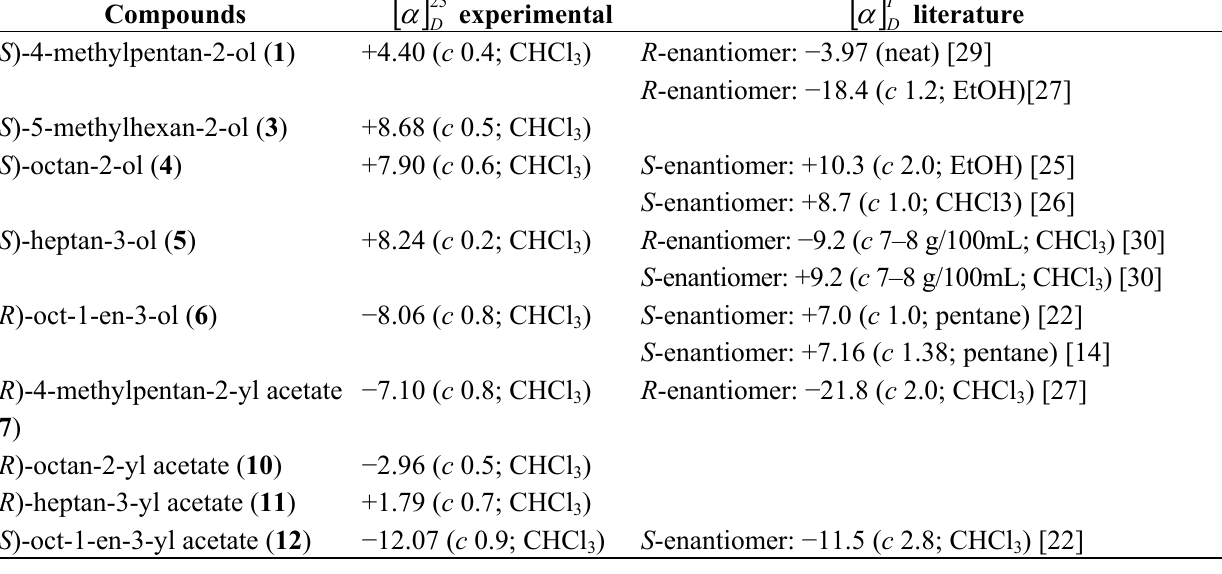
Table 3. Experimental data of optical rotations of the aliphatic secondary alcohols and acetates obtained by lipase B from Candida antarctica